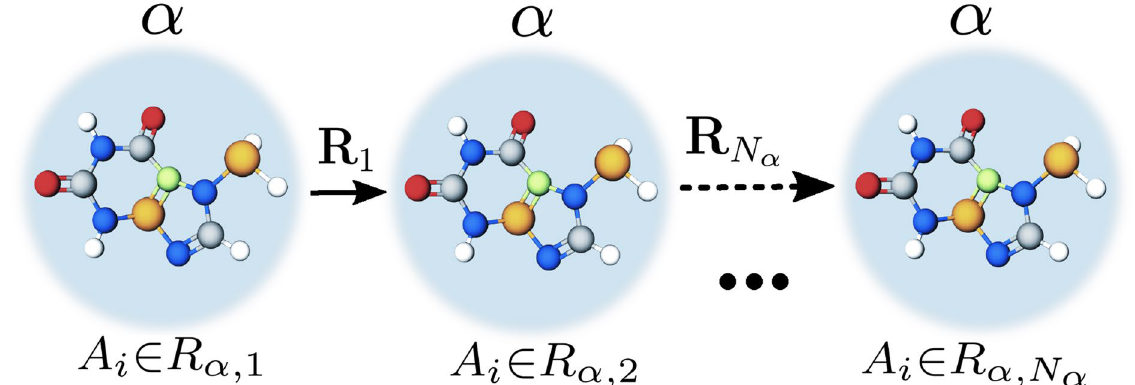
Figure 1. Schematic representation of the main parameters included in the factor δ i , j calculated by the Eq. (6). Multicolored circles are atoms; one color specifies a certain kind of atoms. If the arrangement of atoms in the system is repeated—first, second, etc. up to N α large circles, this sets the symmetry α , and R R R n 1, 2, . . . , n α , . . . , N α large circles. For example, , . . . , R N 1 , 2 , . . . . α are radius vectors setting the position of α the symmetry with α = 1 is represented in this figure, and with α = 2 the location, color, number of circles inside the big circle, number of big circles, and R n 2 would be different.